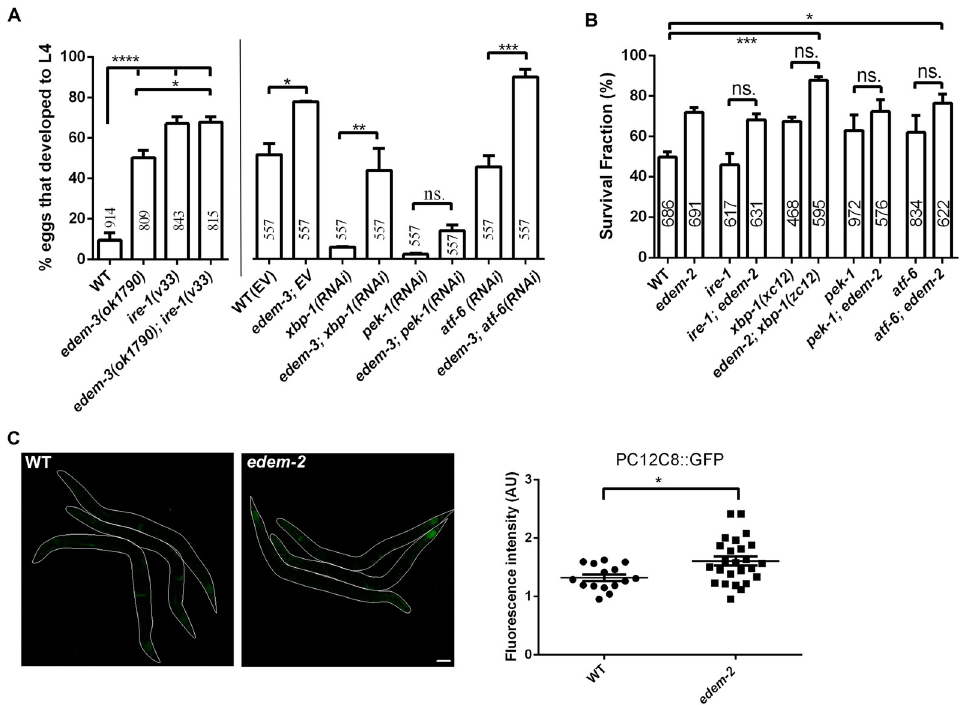
Fig 8. Loss of EDEM-2 and EDEM-3 induces a similar ER stress response as IRE-1 and XBP-1 deficient animals. (A) Percentage of eggs that developed into L4 larvae after 3 days on 4 μ g/ml tunicamycin. Each strain was scored in more than three independent experiments in triplicates. (B) Survival fraction of the indicated strains upon 4h heat stress at 35˚C. Each strain was scored on three replicate plates and each experiment was repeated independently three times. (C) Representative confocal images of WT control or edem-2 young adults carrying the hsp-70 :: GFP (P C12C8 . 1 ::GFP) transgene under heat shock treatment (30 minutes at 35˚C, with 3h recovery). For edem-2 mutants, the strongest expression was observed in the intestine. The worms were outlined for better visualization. Images were obtained using the same confocal settings. Exposure adjustments were uniformly applied. Scale bar: 50 μ m. (D) Fluorescence quantification of P hsp-70 (P C12C8 . 1 ::GFP) transgenic animals presented in (C) . Dots in scatter grams represent mean fluorescence in arbitrary units (AU). The bars indicate the average ± SEM. � P <